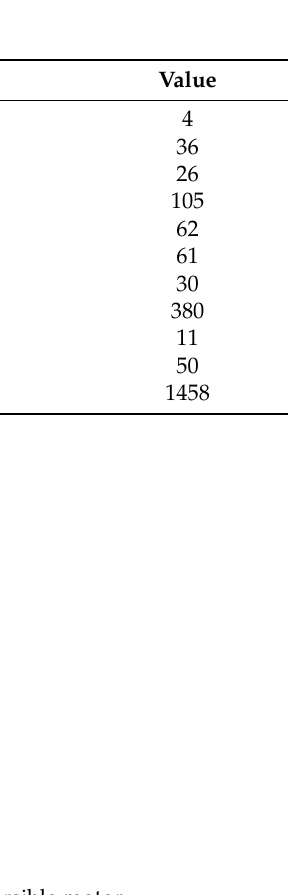
Table 1. The parameters of motor.